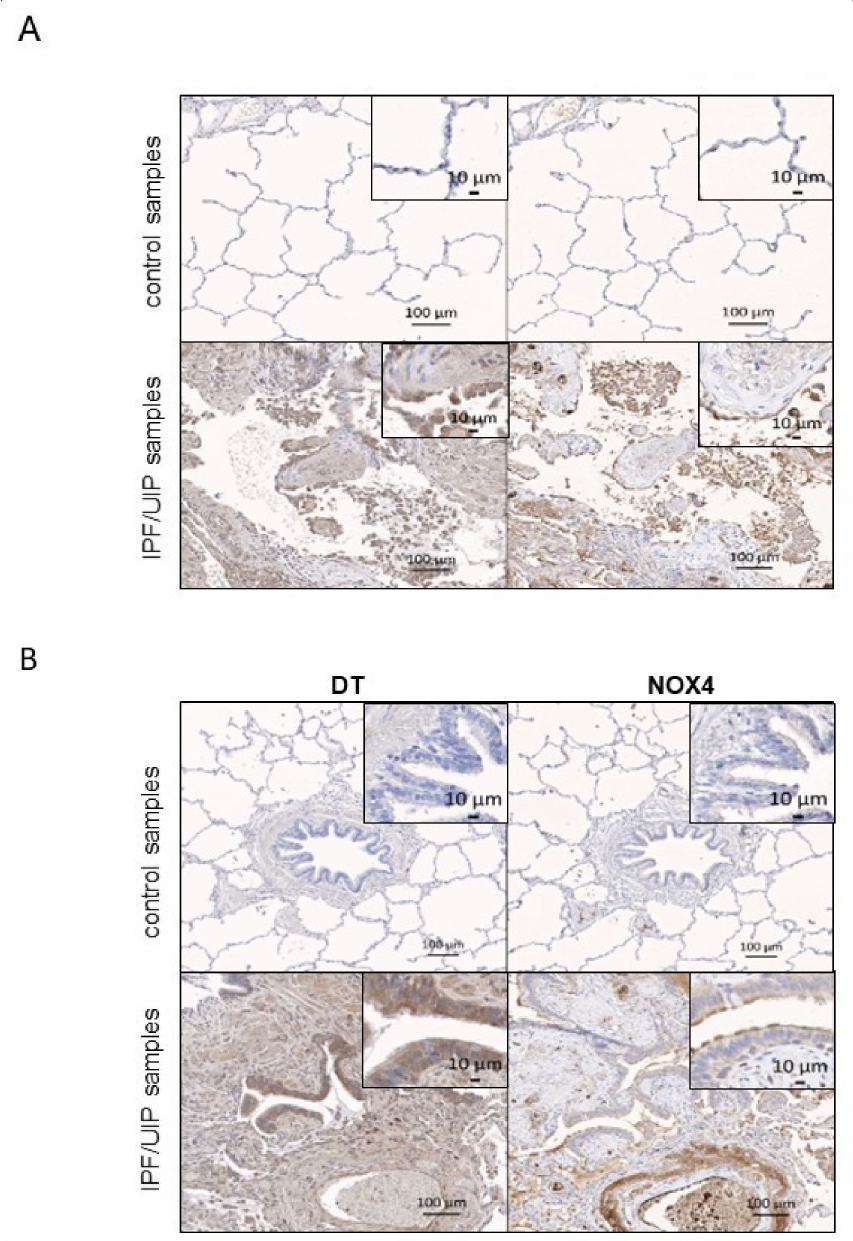
Figure 4. Representative images for DT and NOX4 staining of AECII cells ( A ) and bronchi ( B ) in the control (upper panel) and IPF/UIP samples (lower panel) of human patients are shown. Insets shows a 10 × higher magnification and depicts AECII ( A ) and ciliary bronchial cells ( B ) in these samples. DT and NOX4 staining are shown in